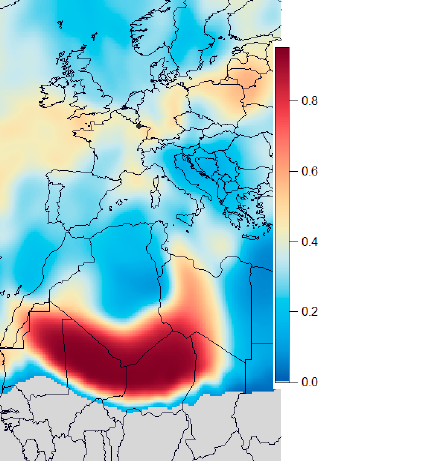
Figure 3. CWT result map for natural-related PMF factors (Aged Sea Salt, Secondary Marine Biogenic, Dust and Primary Biogenic). Red colors highlight potential emission zones. Scales are in µg/m 3 . Note that 10-day back trajectories were used for the Dust factor.